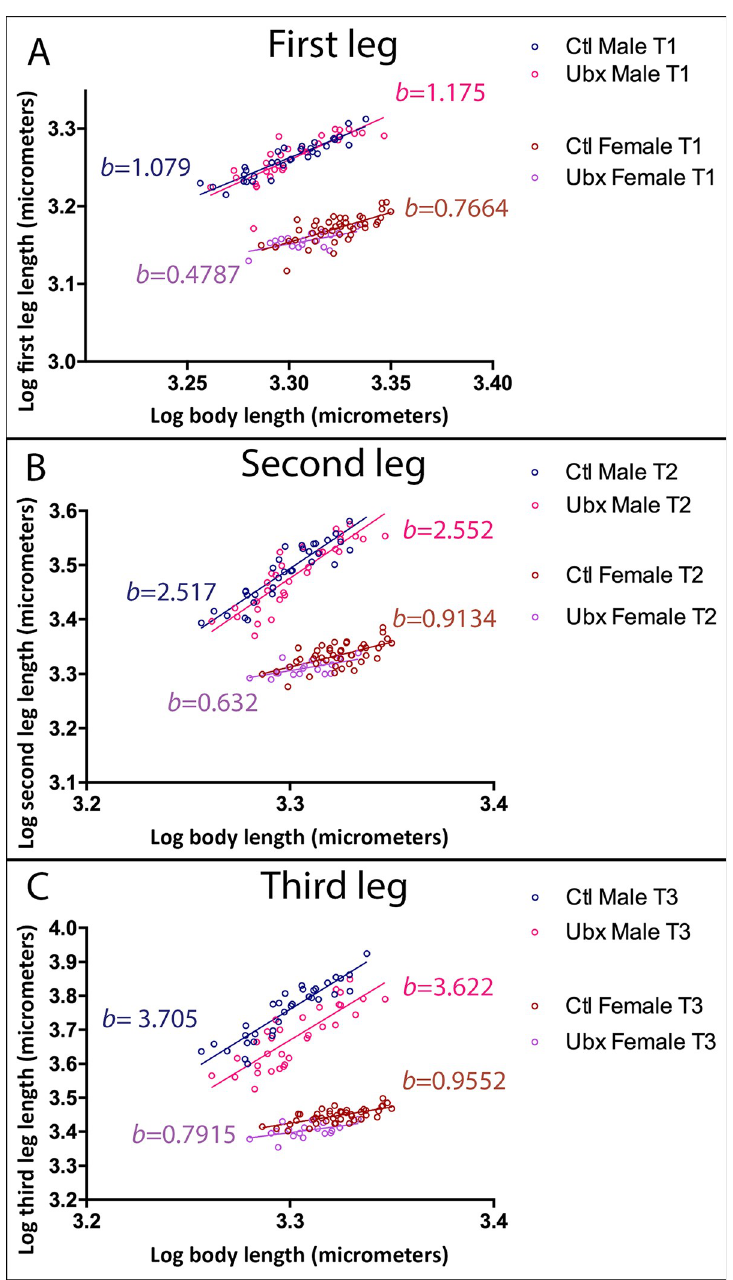
Fig 2. Effect of Ubx RNAi on scaling relationships between leg length and body length in M . longipes . (A) Scaling relationships are not altered in males or females by Ubx RNAi. (B) There is a subtle decrease in the intercept of second legs upon Ubx RNAi. (C) Ubx RNAi causes a significant decrease in intercept of the third legs in males. Note that body size is not affected by Ubx RNAi. Linear regressions were fitted to the log-transformed datasets. Statistical analyses were also performed on log-transformed data and can be found in S6 Table. Sample sizes are as follows: control males n = 33; control females n = 44; Ubx RNAi males n = 32; Ubx RNAi females n = 18. The data underlying this figure may be found in S6 and S7 Tables. Ctl, xxxx; RNAi, RNA interference; Ubx , Ultrabithorax .